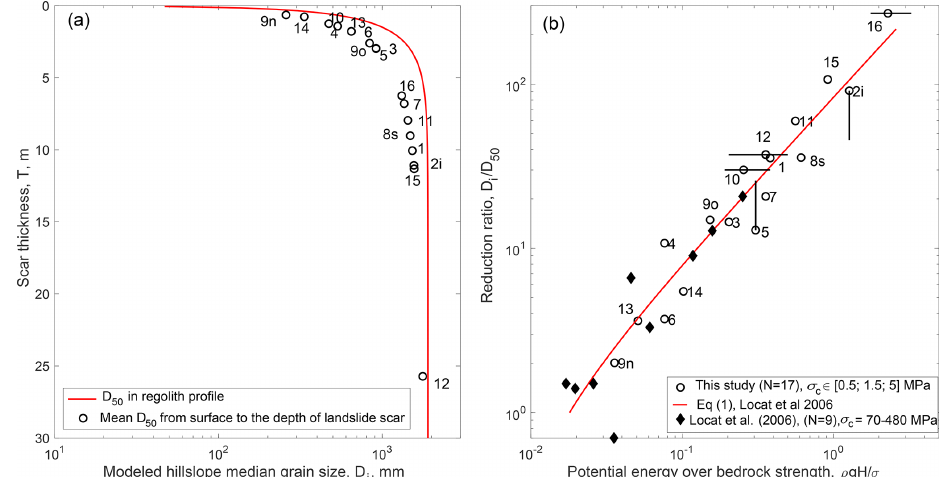
Figure 6. (a) Grain size as a function of depth in the regolith inspired by the weathering model of Cohen et al. (2010), used to estimate the original median grain size, D i , mobilized by landslides with different thicknesses. (b) Reduction ratio, using the modeled D i from panel (a) , against the potential energy normalized by point load strength estimate for the 17 landslide deposits in this study. The error bars are the same as in Fig.